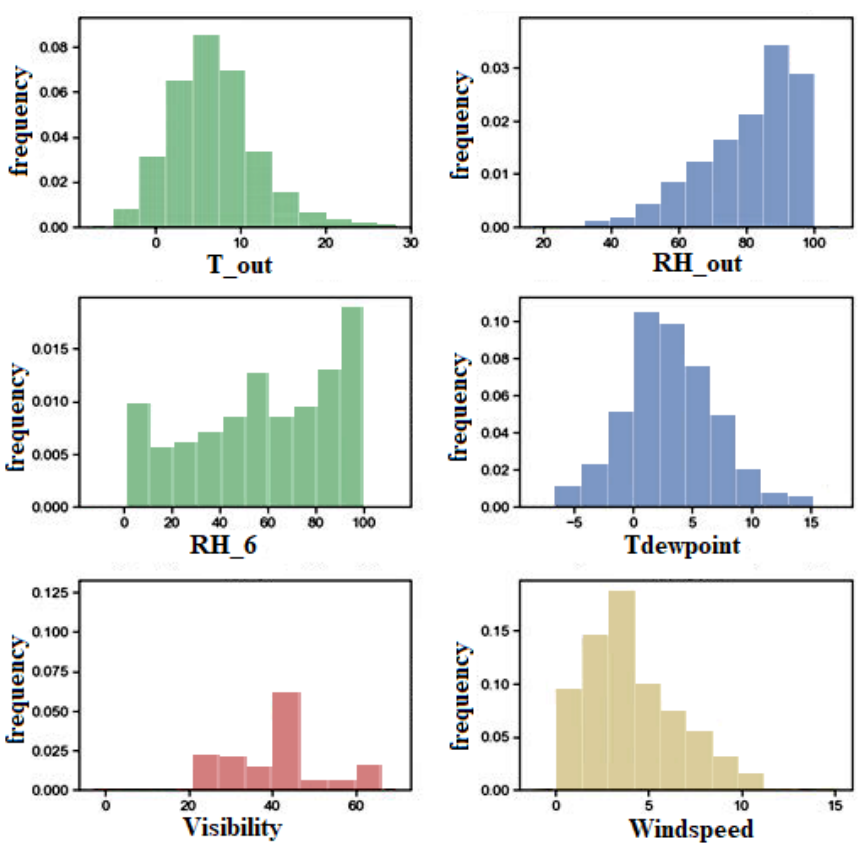
Figure 5. Distribution of the various features of the UCI household energy